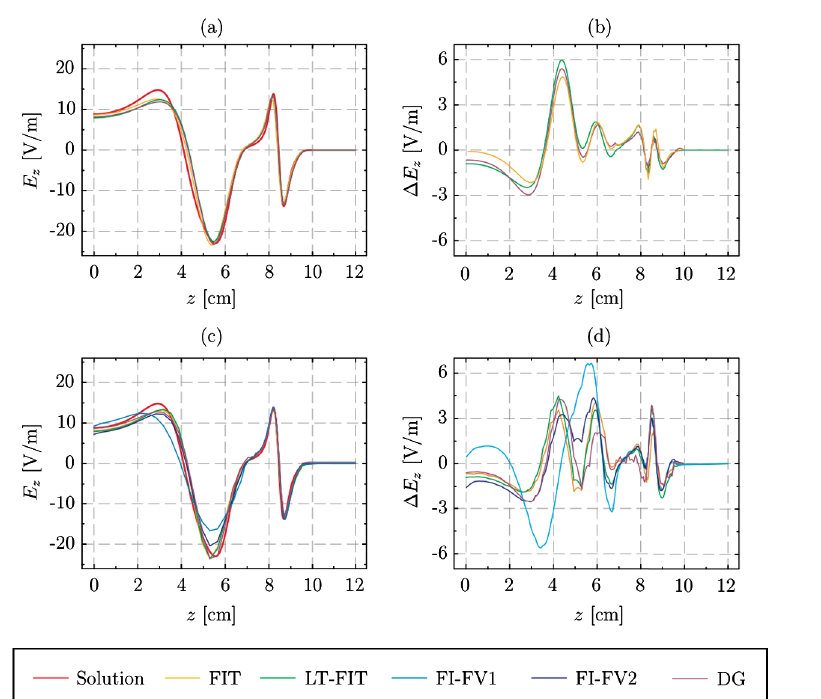
FIG. 10. Longitudinal component of the electric field, excited by a Gaussian bunch traveling in a pipe. The black curve in (a) and (c) indicates the analytical solution for the setup described in Table I. All other curves show results obtained from numerical simulations. In the top row, a static, equidistant computational grid was applied. The results are shown in (a), their errors in (b). In the bottom row, time-adaptive grid refinement ( L ¼ 3 ) was applied. In (c) the results for this case are shown, in (d) the